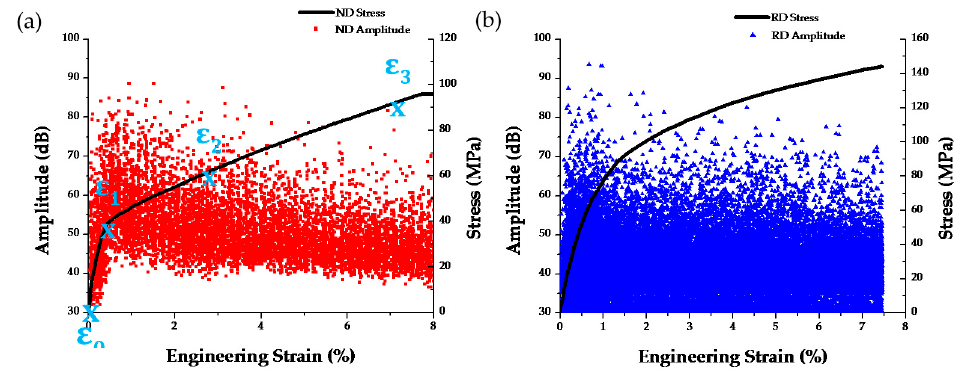
Figure 7. Stress strain curve and corresponding AE amplitude distribution of tensile tests of: ( a ) ND and ( b ) RD specimens